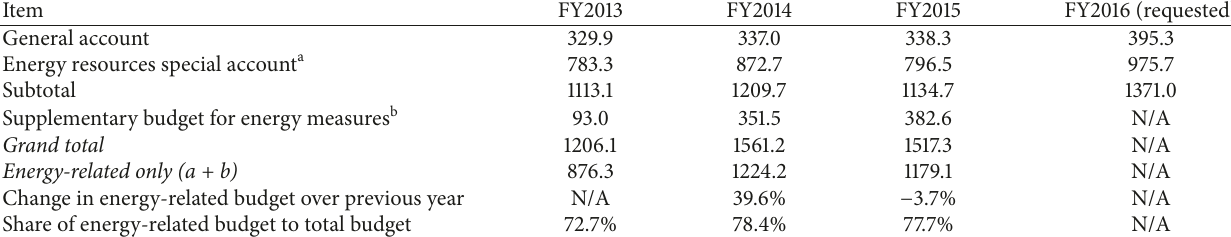
Table 1: METI budget allocations (billions of